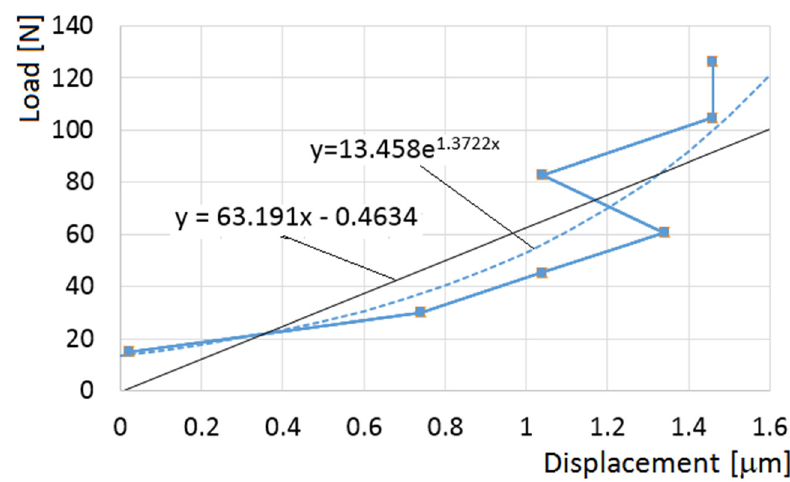
Figure 13. Static stiffness characteristic at position 8 when the latter is assumed in the − X direction (force F a ).